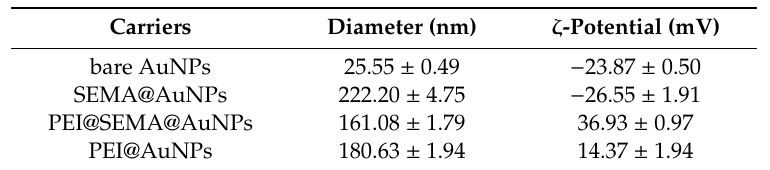
Table 1. Size and surface charge of bare AuNPs and SEMA@AuNPs, PEI@SEMA@AuNPs, and PEI@AuNPs. All measurements were performed in triplicate manner, and each value was presented as average and standard deviation ( n = 5).